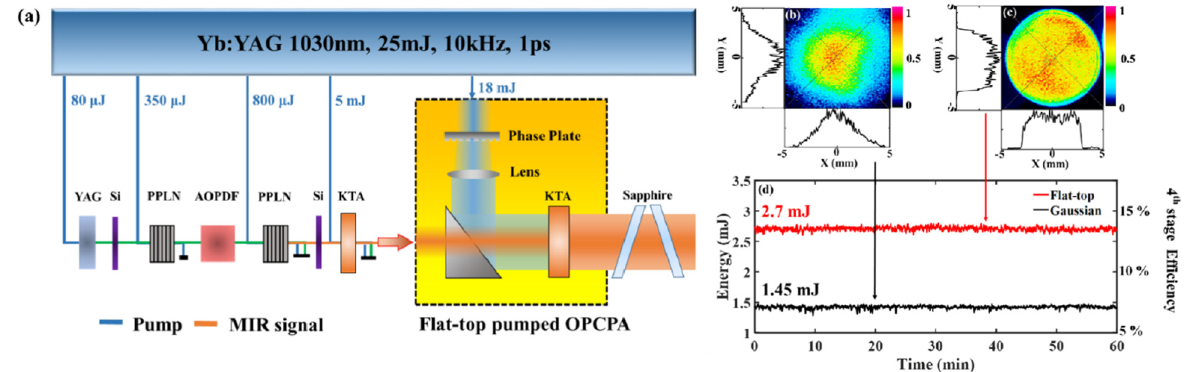
Figure 11. ( a ) The schematic of flat-top beam shaping of the high-energy and high-average-power 3 μ m OPCPA. The MIR pulses centered at 3 μ m were generated and amplified to 300 μ J from 3-stage OPCPA preamplifiers via periodically poled lithium niobate (PPLN) and KTA crystals. The 4th OPCPA stage was designed to boost up the MIR output and enhance the parametric efficiency through the flat-top beam shaping. The Gaussian pump beam of the 4th-stage OPCPA was sent to a flat-top beam shaper consisting of a phase plate and a focus lens, and the flat-top pump beam is formed at the imaging plane of the lens. The Gaussian idler beam generated from the first 3 OPCPA stages was amplified with a flat-top pump, producing a high-energy and high-average-power flat-top-like 3 μ m output. The measured pump beam profiles ( b ) with and ( c ) without the flat-top beam shaper on the KTA crystal. The cross-section beam profiles on the x and y axes are included too. ( d ) The pulse energy measurements of the 3 μ m idler pulse from the OPCPA with flat-top (red) and Gaussian (black) pump beam profiles. 2.7 mJ and 1.45 mJ MIR pulse energy were obtained from the flat-top and Gaussian pump, corresponding to 7% and 13.5% pump-to-idler efficiency for the 4th-OPCPA stage, respectively. Reprinted with permission from [45].